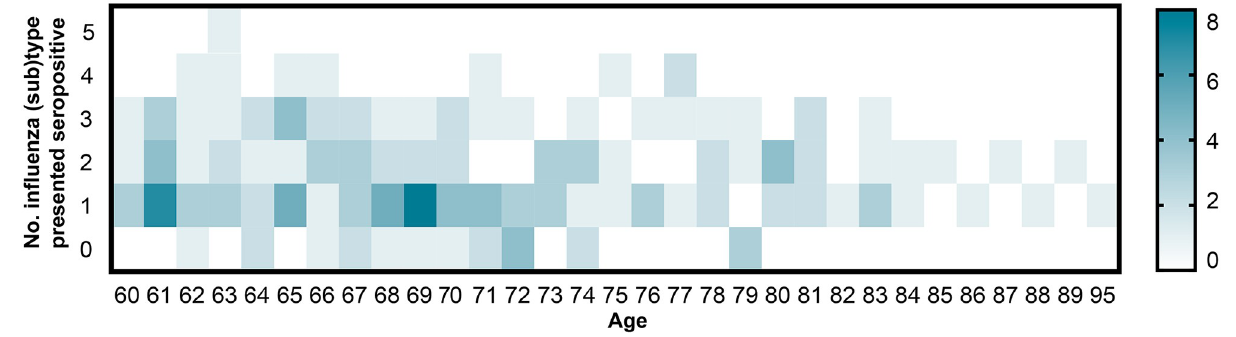
Fig 4. Schematic representation of the number of influenza type or subtype presenting seropositivity (HAI titer � 1:40) for the individual. The X- axis indicates the age range of the elderly, and the Y-axis represents the number of seropositive influenza type or subtype. Colored intensity indicated the number of